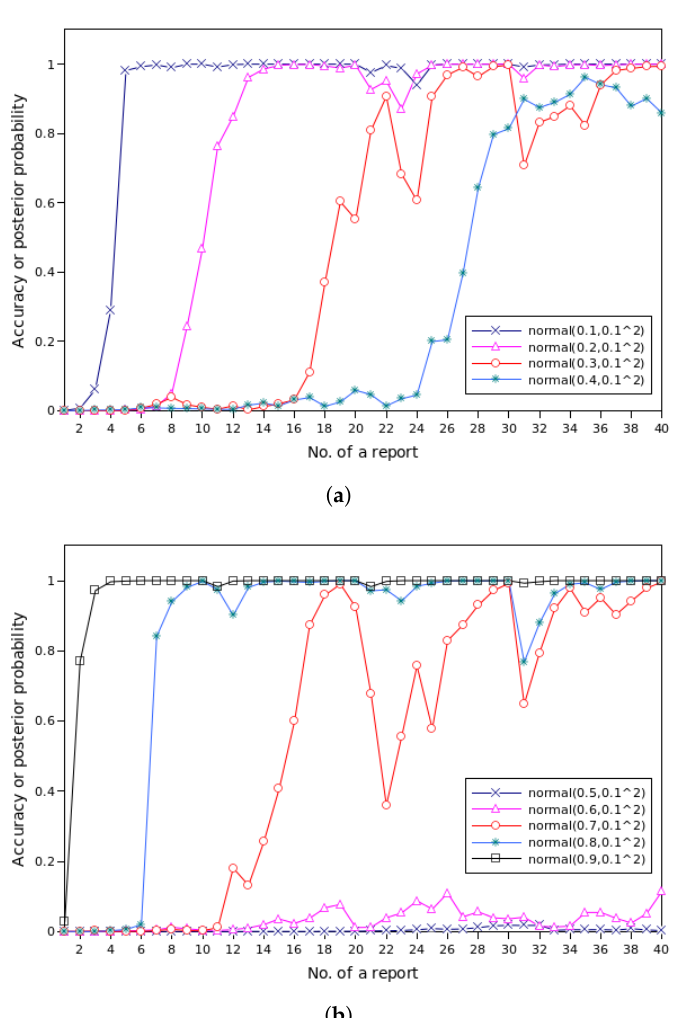
Figure 13. The accuracy or posterior probability of QcFND. ( a ) Vehicles with low level of trust. ( b ) Vehicles with high or middle level of